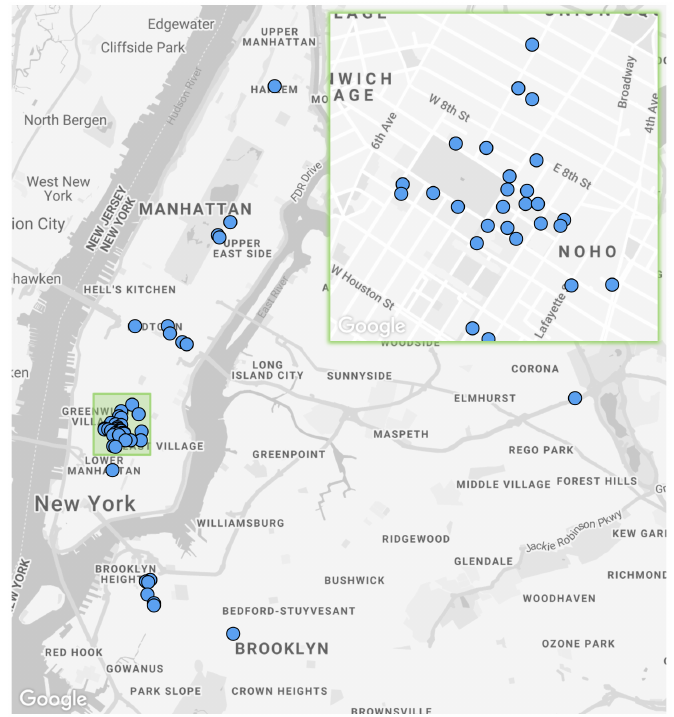
Figure 2. Sensor network deployment map with an entire network of 55 sensors and a green focus area of dense Washington Square Park